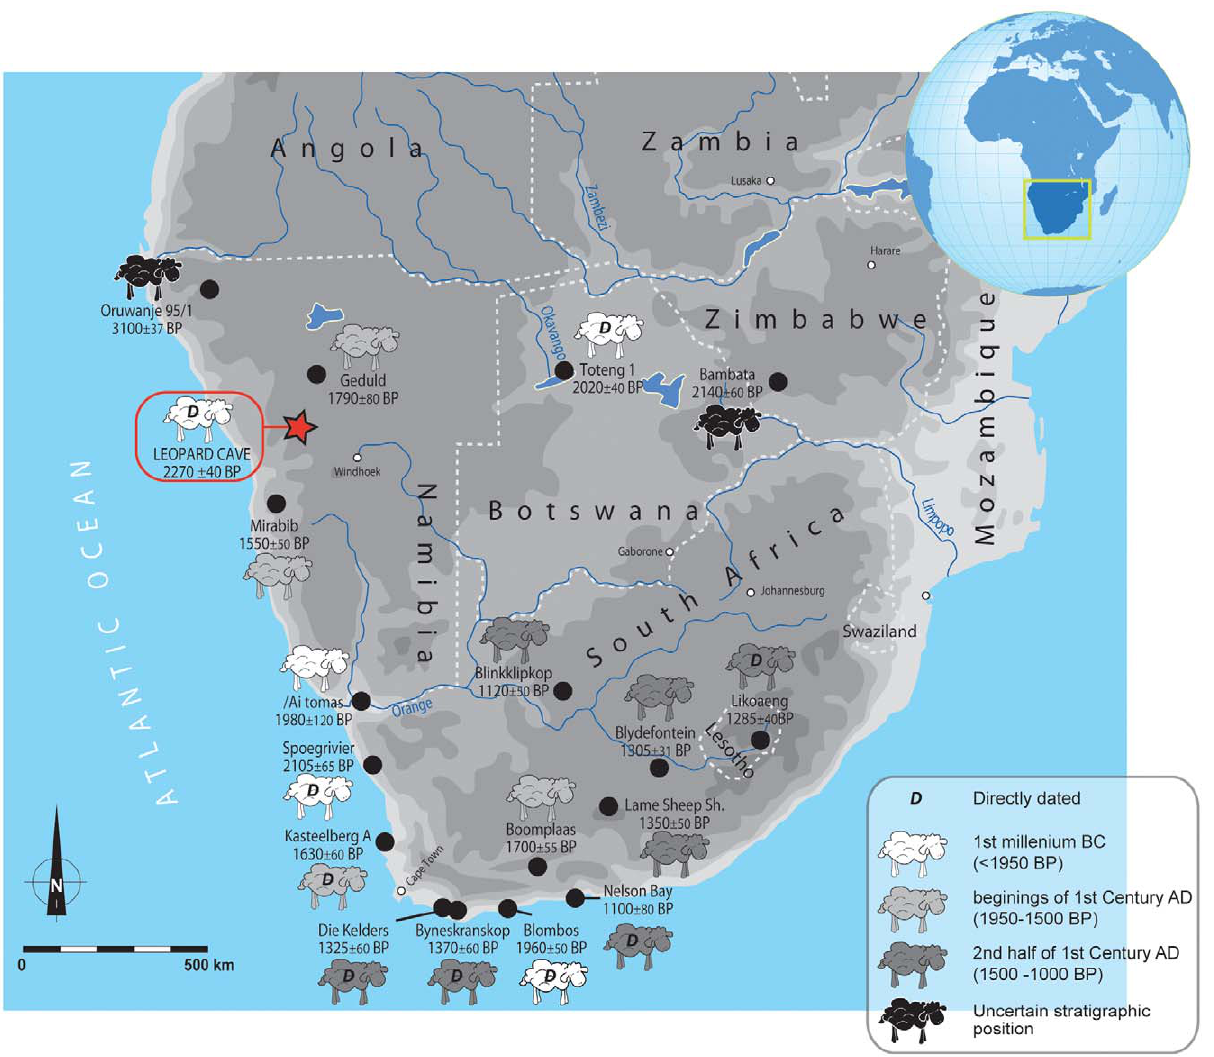
Figure 4. Later Stone Age sites of southern Africa with early evidence of caprines (after [ 15–17,19,30,34,57,72,83–87 ] ).